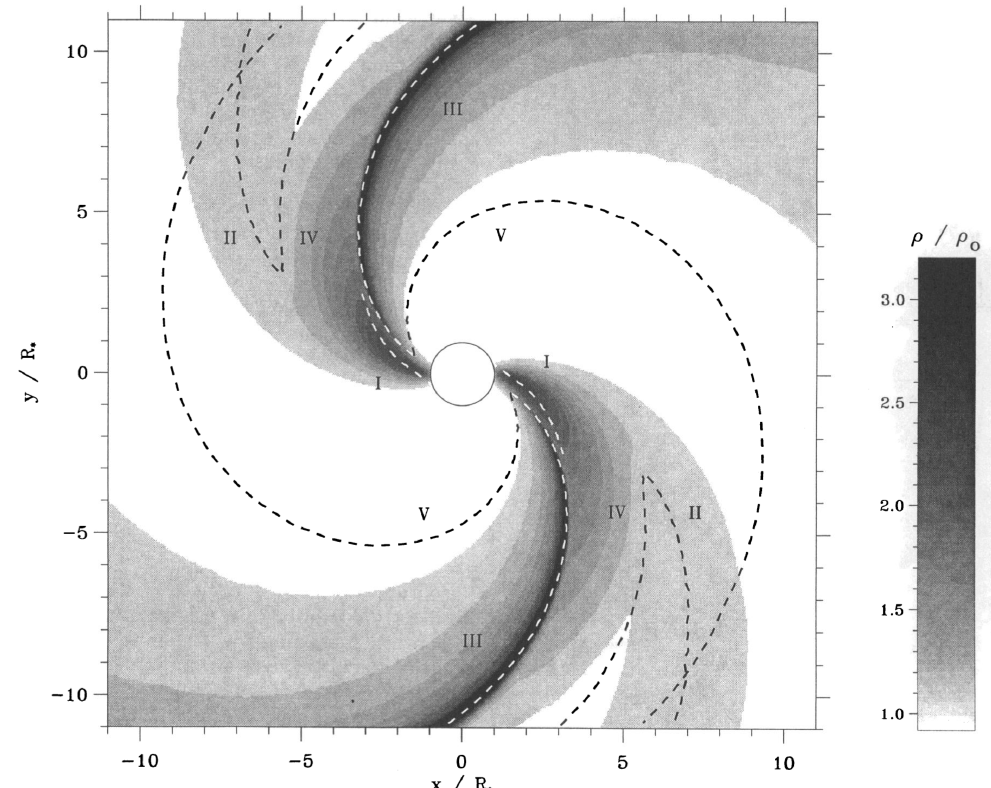
Figure 3. Hydrodynamical simulation showing the density distribution in the equatorial plane of CIRs in the wind of a massive hot star like ζ Pup [16]. The CIRs are driven by two arbitrarily assumed diametrically opposite corotating bright spots on the stellar surface. The Roman numerals and dashed curves highlight different regions [16]. ©AAS. Reproduced with